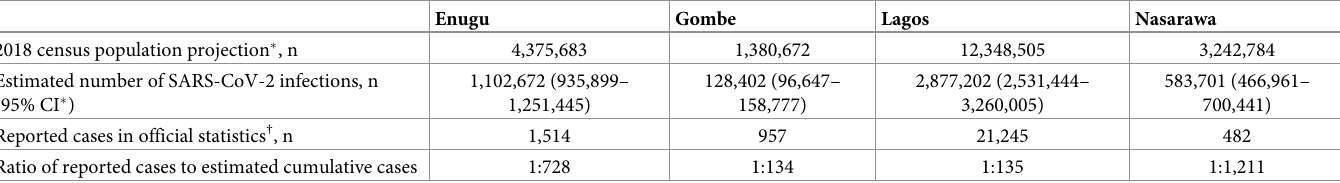
Table 3. Estimated number of cumulative SARS-CoV-2 infections in four states in Nigeria (October 2020). Enugu Gombe Lagos